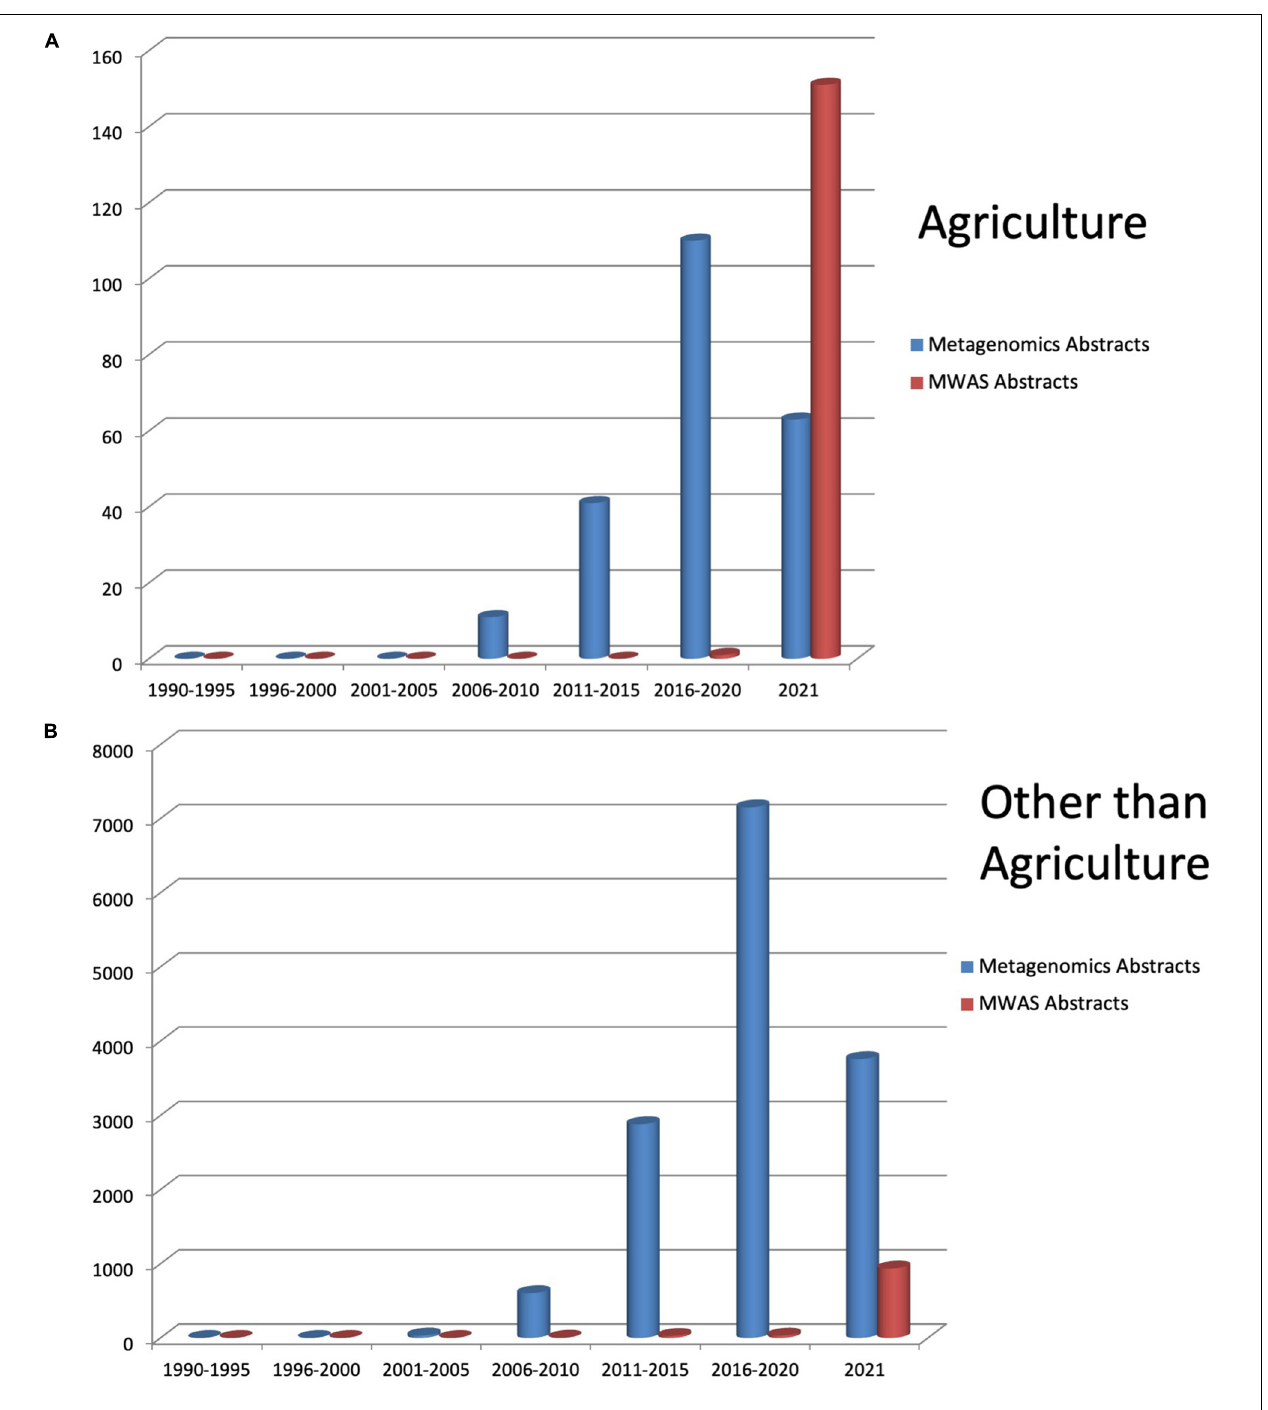
FIGURE 1 | Literature reported in PubMed for metagenomics and metagenomics wide association studies from 1990 till 2021 in (A) agriculture and (B) other than agriculture.